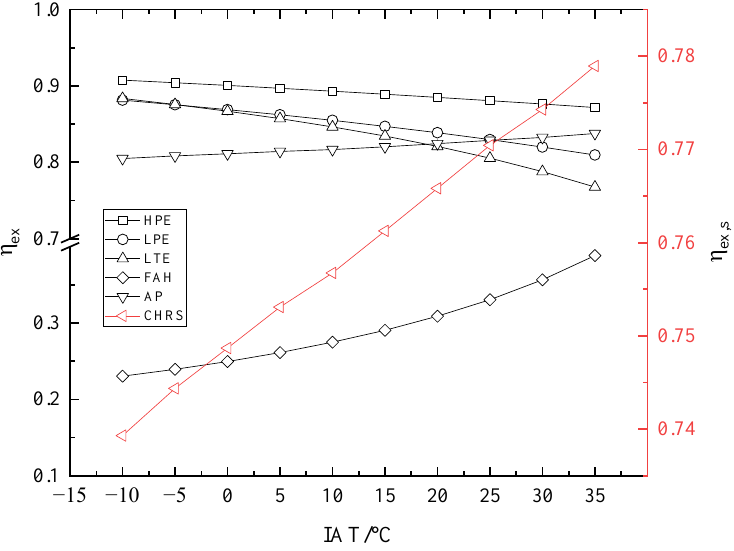
ffi ciency of heat exchangers and CWHRS under di ff erent IAT. Figure 9. Exergy efficiency of heat exchangers and CWHRS under different IAT. Figure 9. Exergy e